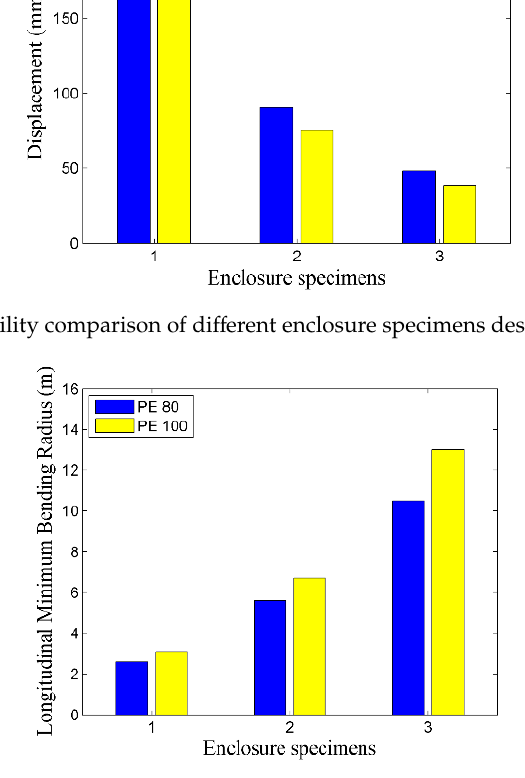
Figure 5. Longitudinal minimum bending radius (LMBR) comparison of different enclosure specimens described in Table 2.